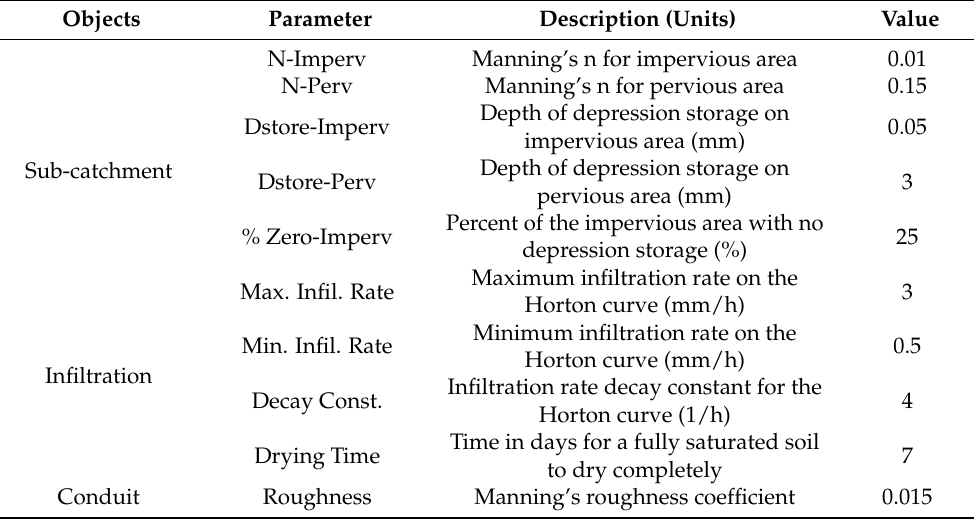
Table 2. Conduit and sub-catchment parameters used in simulation.